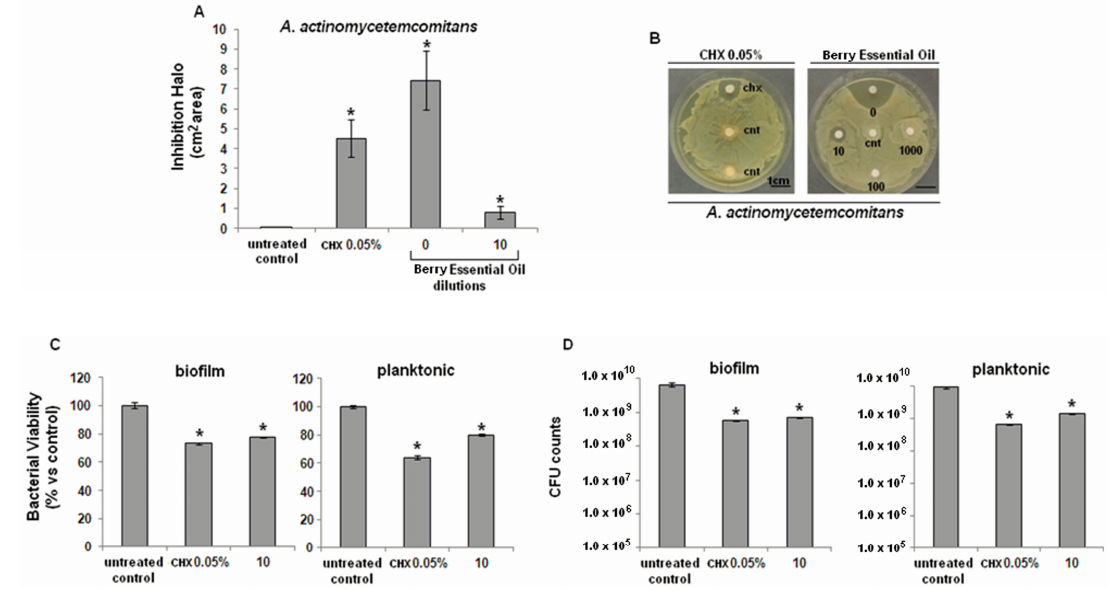
Figure 2. Antibacterial activity of J. excelsa EO against A. actinomycetemcomitans . ( A ) Bacteria growth was inhibited by pure (0) or 1/10 diluted EO (10); inhibition was statistically significant in comparison with controls (cnt) ( p < 0.05, indicated by the * ); ( B ) higher EO dilutions (100 or 1000) were ineffective; ( C ) XTT assay revealed a similar activity between CHX and EO (10), statistically different towards controls ( * p < 0.05) for both biofilm (left) and planktonic (right) cells; ( D ) CFUs counts showed that CHX and EO (10) determined a similar significant reduction of about 1.5 logs in comparison with control ( * p < 0.05) for both biofilm (left) or planktonic (right) cells. Data are expressed as mean ± standard